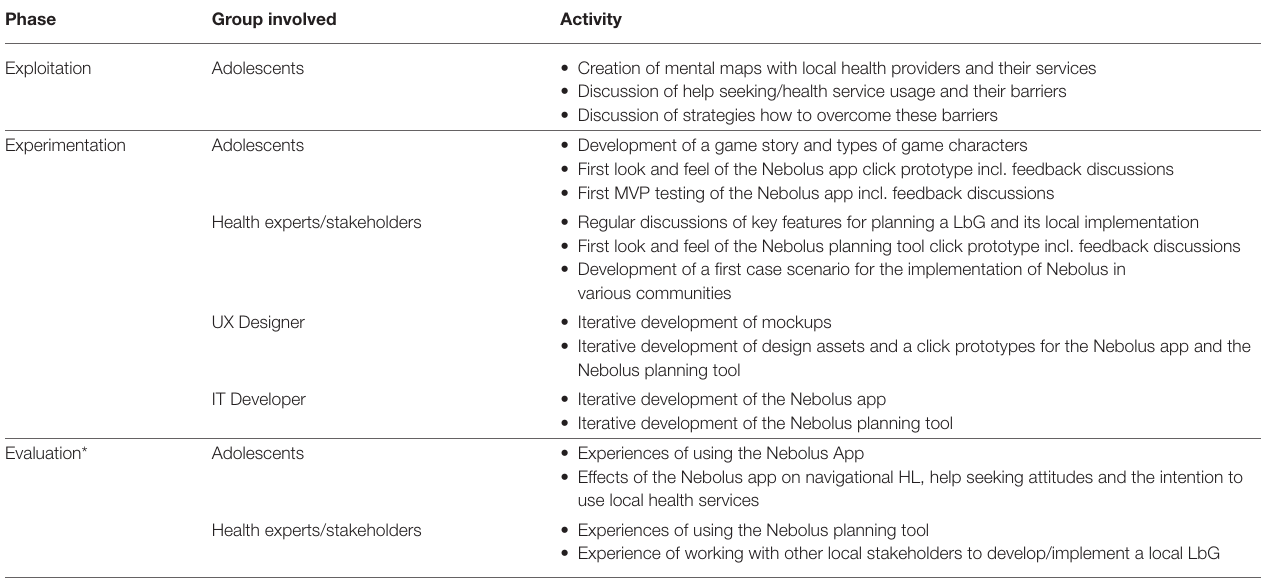
TABLE 1 | Co-creation of Nebolus using the living lab approach.